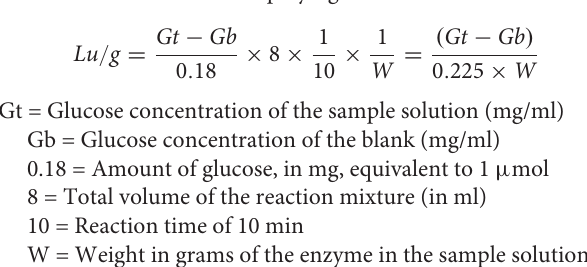
Table 3 at a constant flow rate of 1.0 ml min − 1 at 30 ◦